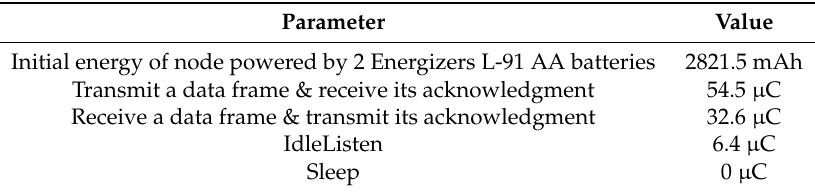
Table 2. Parameters used for network lifetime